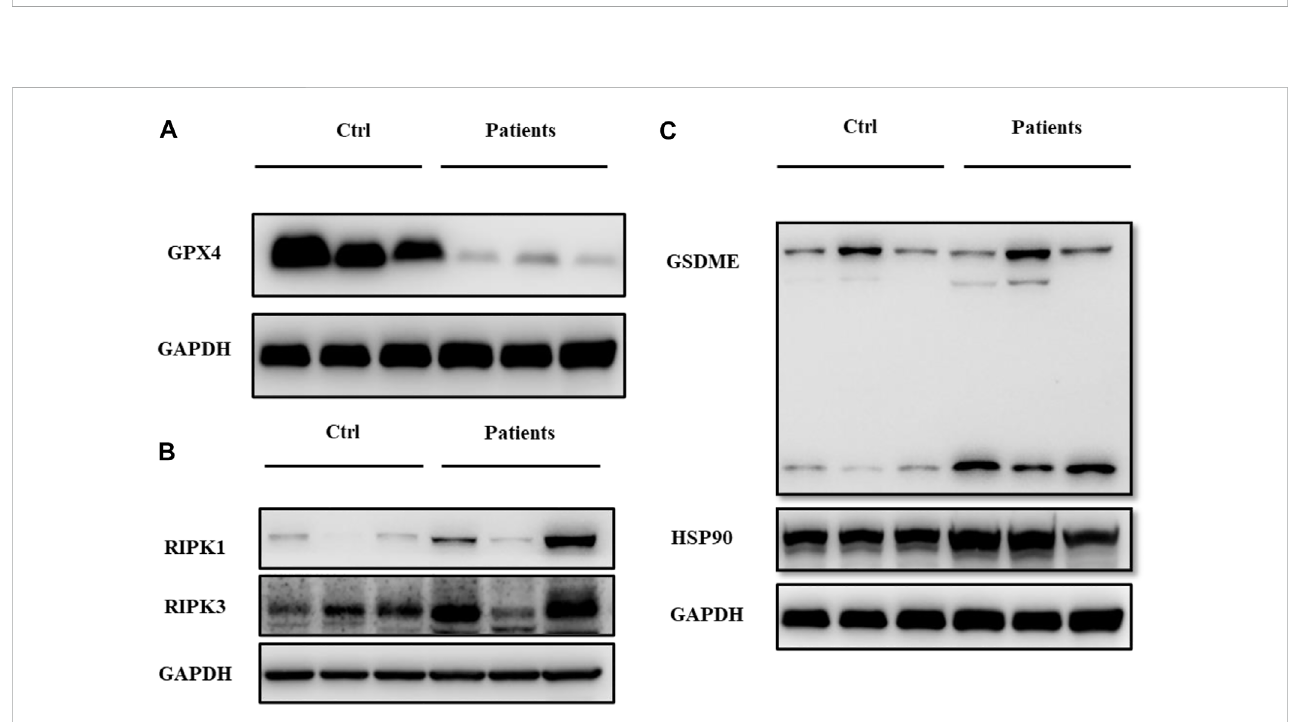
ROS exposure activated ferroptosis, necrosis and pyroptosis-related signal pathways in human spermatozoa. (A) Relative protein expressions of GPX4. (B) Relative protein expressions of RIPK1 and RIPK3. (C) Relative protein expressions of GSDME and HSP90.